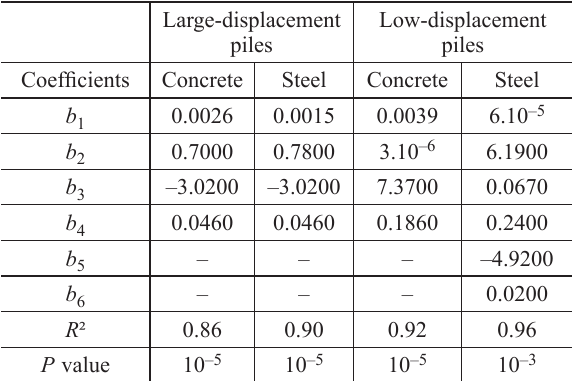
Table 7. Parameters of the statistical models based on neural network results Large-displacement